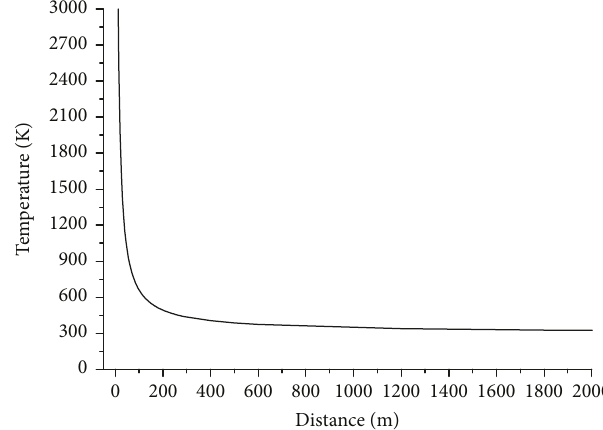
Figure 3: Calculated air temperature distribution in the tunnel.